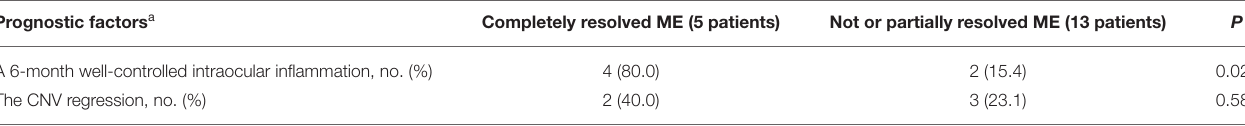
TABLE 4 | Prognostic factors for the resolution of ME with a concurrent CNV in VKH patients. Prognostic factors